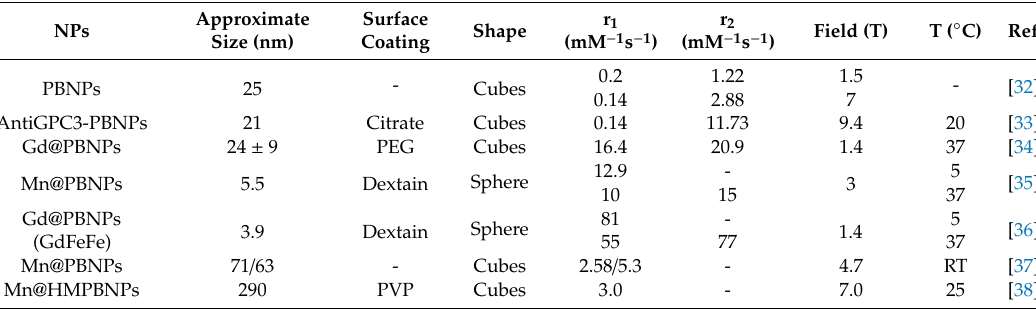
Table 1. Summary of MR relaxivities based on